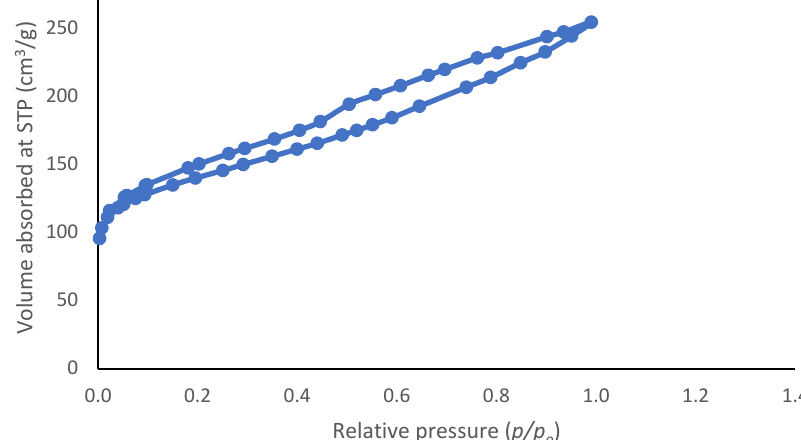
Figure 3. Nitrogen adsorption and desorption isotherms of the fresh Pt/C catalyst.